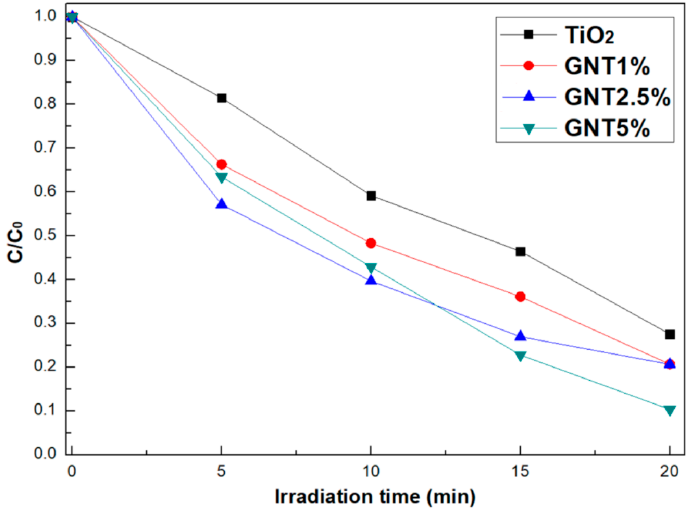
Figure 10. Photocatalytic degradation kinetics of methylene blue (MB) in the presence of TiO 2 and TiO 2 /g-C 3 N 4 fibers under solar light irradiation.